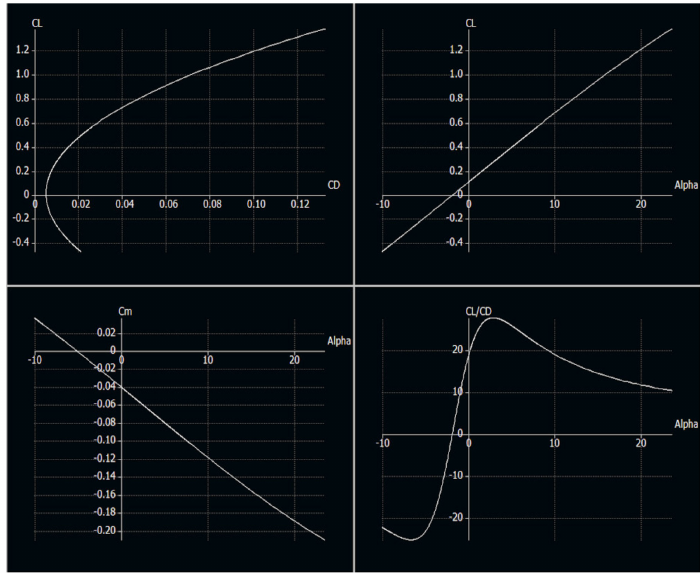
Figure 1. XFLR5 (v6.47) Results. Top-left: C L vs C D . Top-right: C L vs angle of attack. Bottom-left: C m vs angle of attack. Bottom-right: C L / C D vs angle of